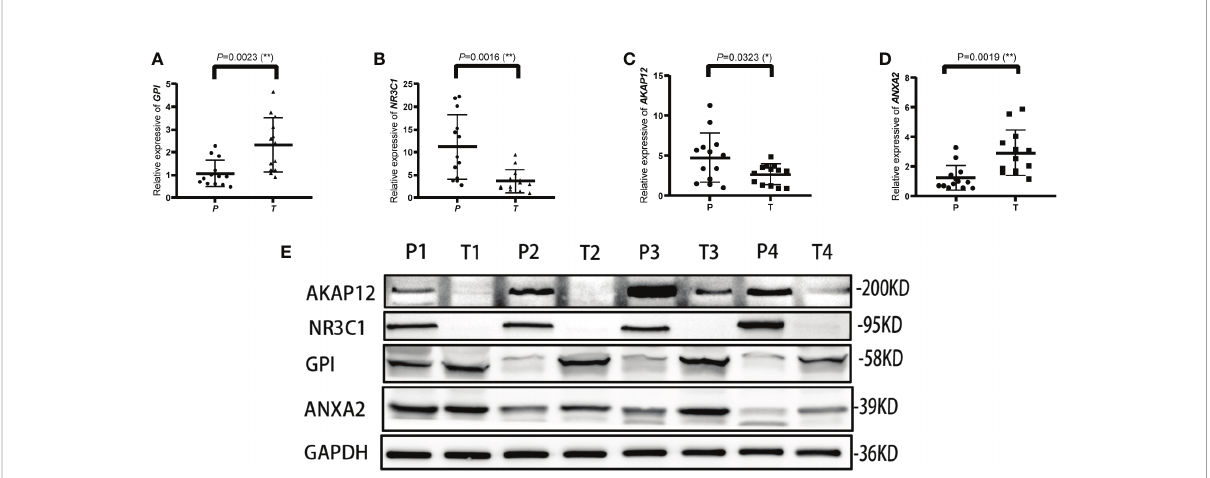
FIGURE 9 Validation of the relative expression level of ANXA2, AKAP12, NR3C1 and GPI in para-carcinoma tissues (P) and tumor tissues (T) using qRT-PCR (A – D) and western blot (E) . * represents a p value < 0.05, ** represents a p value <